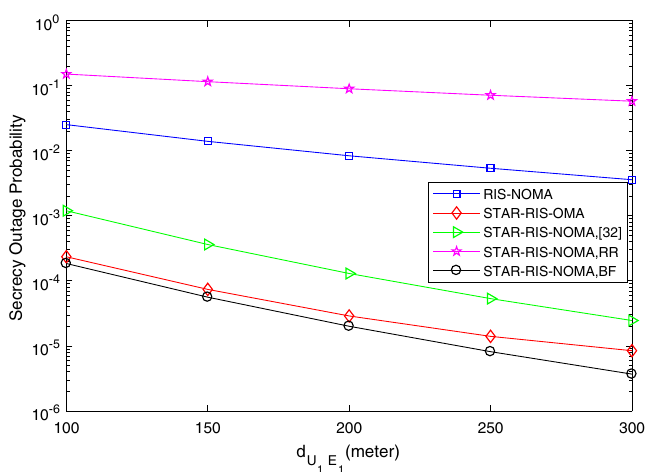
Fig. 5 The SOP versus the different distances from the cell-edge user to eavesdropper, i.e., d U 1 E 1 . When the transmission power is constant, the influence of different distances on the SOP